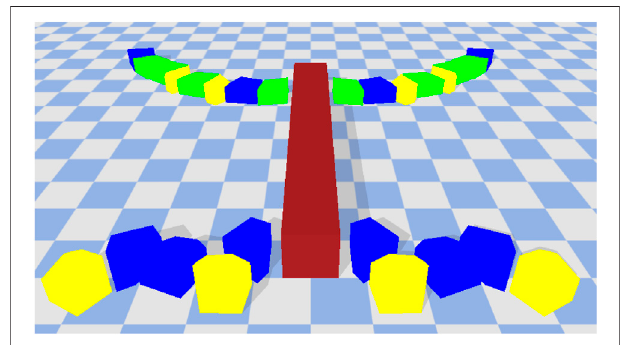
FIGURE 4 | An example of a complete robot. The colors denote friction values. Green (cid:2) 0.25, Red (cid:2) 0.5, Blue (cid:2) 0.75, and Yellow (cid:2) 1.0. The cross- section(maroon)isalwaysgivenadefaultfrictionvalueof0.5.Therobotinitially starts in a fl at position but can move in several ways including crawling, jumping, walking and so on.